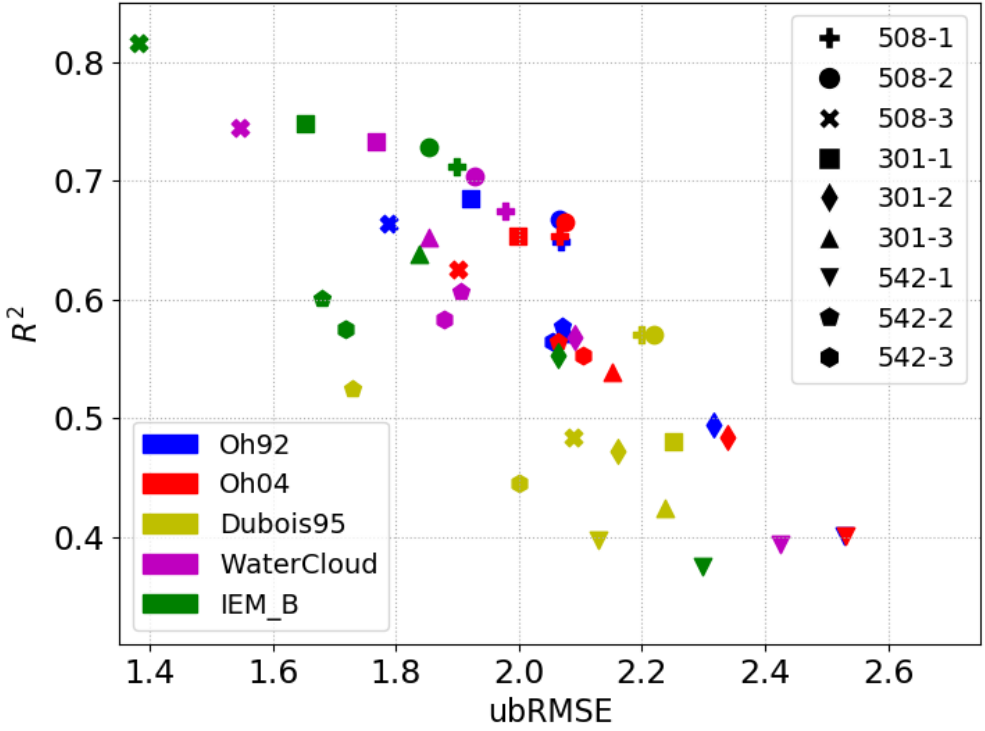
Figure 10. Scatter plot showing statistical validation results (correlation coefficient R 2 and ubRMSE) for canopy model SSRT separated by different surface models (colors) and different field points